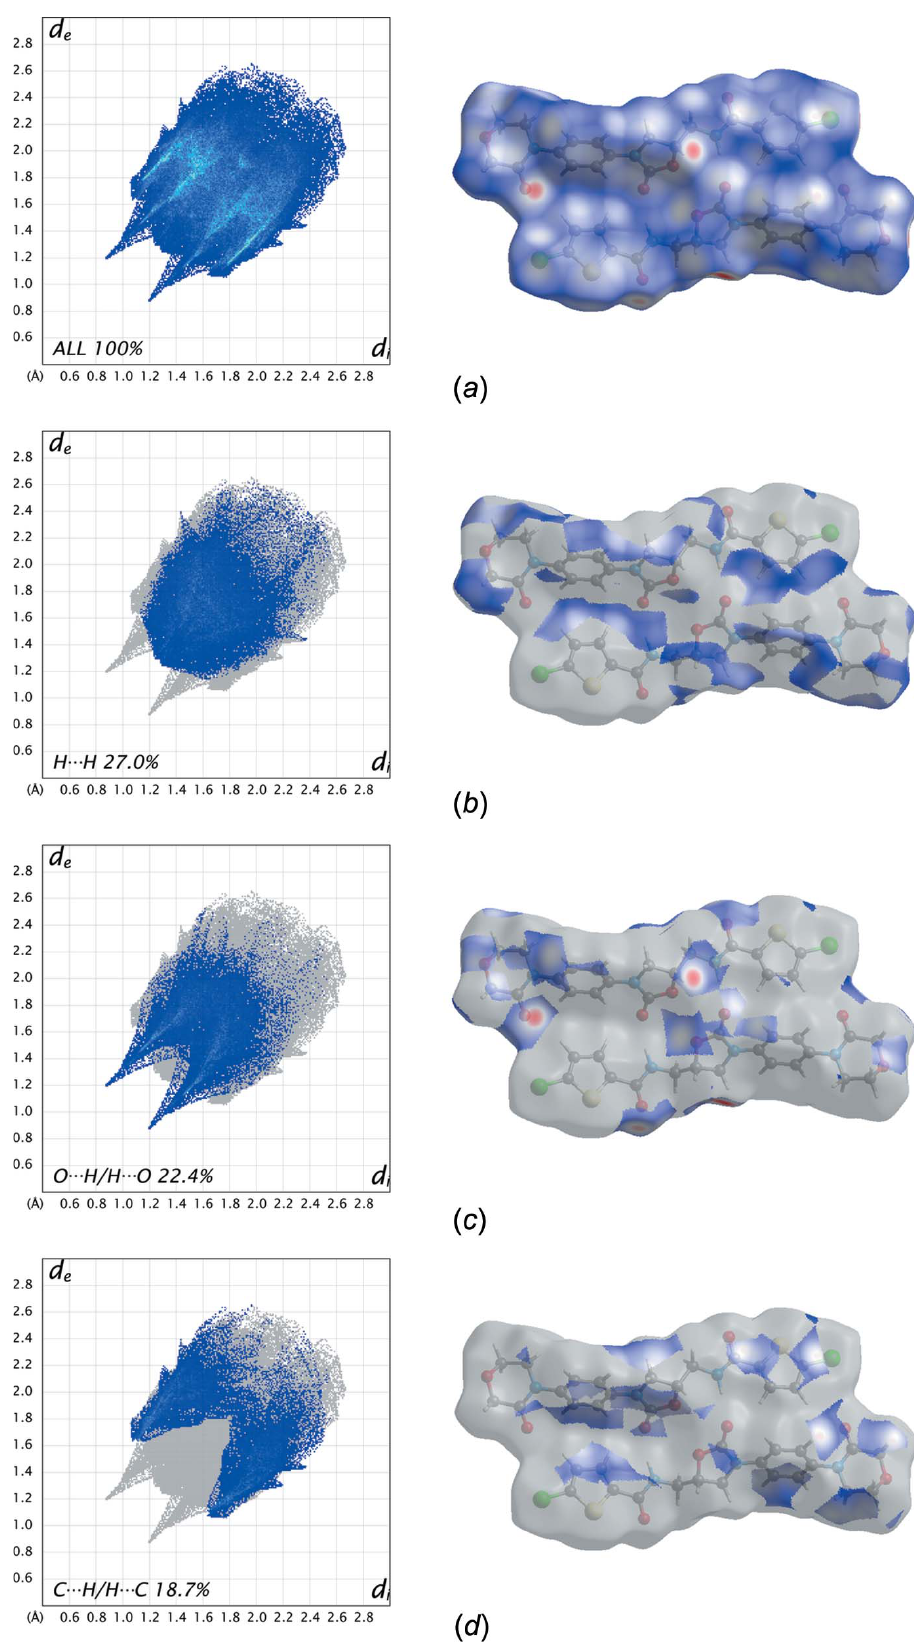
Figure 4 The two-dimensional fingerprint of title compound showing contributions from different